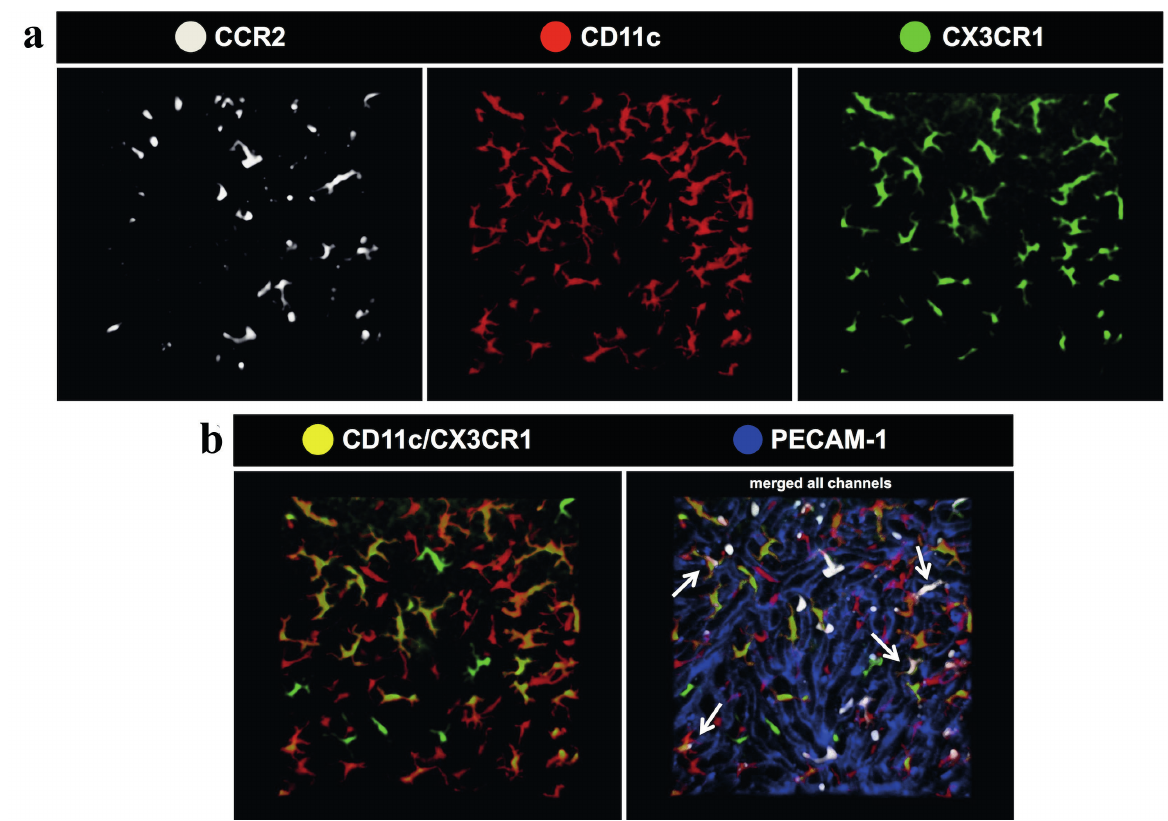
Figure 6 - Efficient spectral separation of liver phagocytes from triple fluorescent mouse CX3CR1 gfp/wt CCR2 rfp/wt CD11c-eYFP during confocal intravital microscopy. ( a ) Separated channels from the different populations CCR2+ (white), CD11c+ (red) and CX3CR1+ (green). ( b ) Merged channels showing populations of double-positive cells for CCR2 and CX3CR1 (yellowish cells) and the compartmentalization (intra or extravascular) of cells using PeCAM-1. Arrows depict triple positive